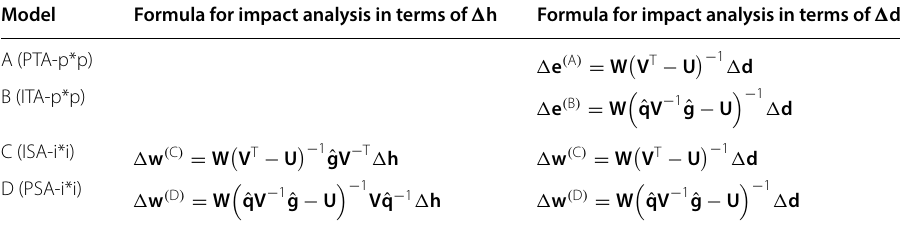
See “Appendix 1” for the proofs